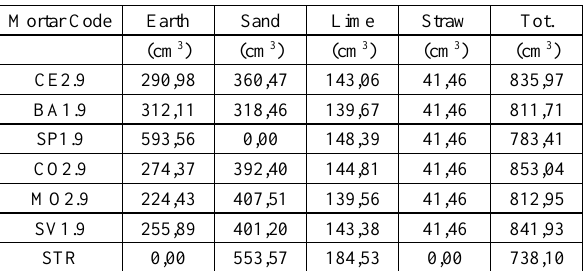
Table 4. Mortars composition, in volume, for 1 kg material, produced by the authors.